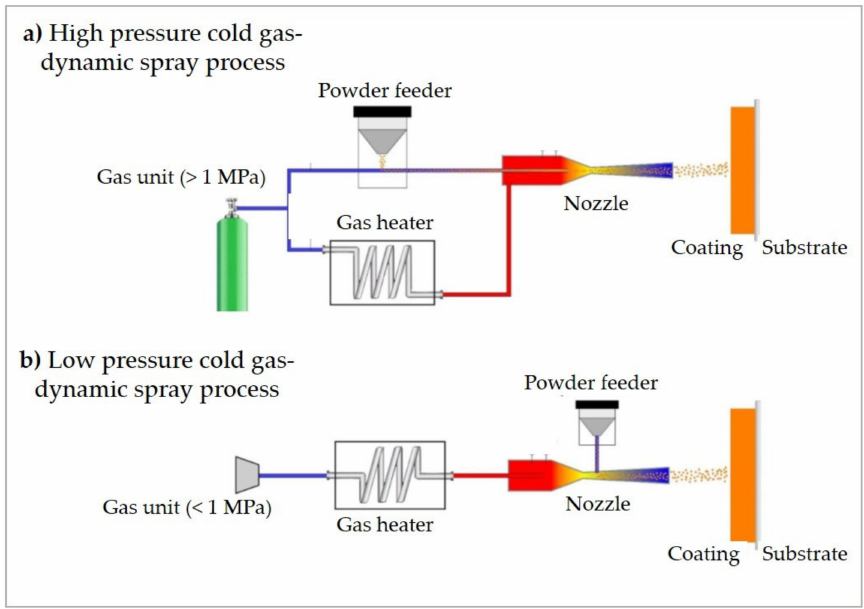
Figure 1. Schematic representation of the various cold gas-dynamic spray processes: ( a ) high pressure cold gas-dynamic spray process (HPCGDS), ( b ) low pressure cold gas-dynamic spray process (LPCGDS)